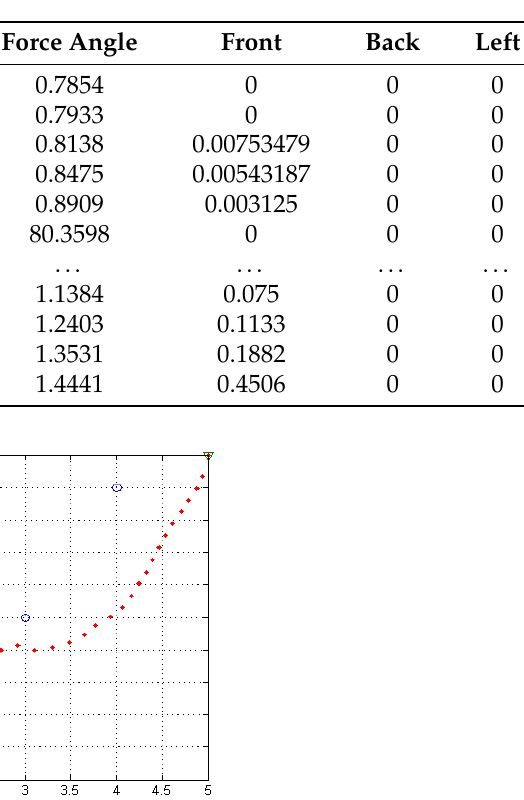
Table 1. The experimental results corresponding to Figure 7 and the results of initialization according to Figure 6.